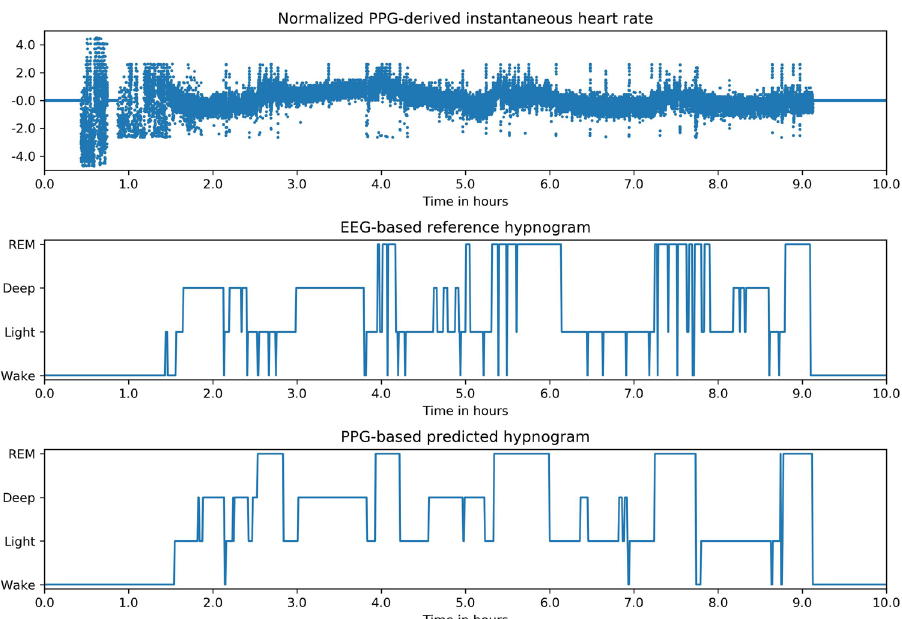
Fig. 8 Demonstration on wrist-worn PPG. Example of a hypnogram predicted by our algorithm using heart rate extracted from wrist-worn PPG device compared with the hypnogram predicted by an EEG based automated sleep scoring